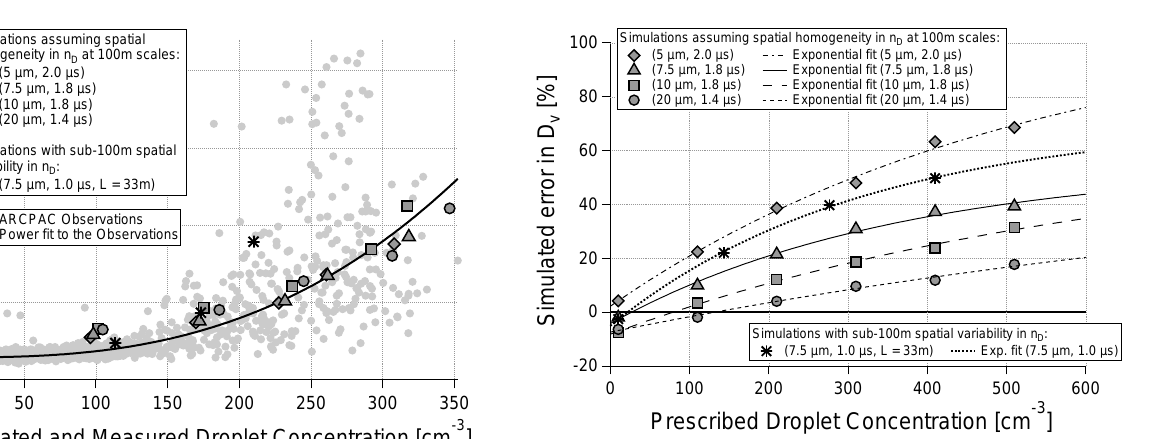
Fig. 11. Simulated and observed average transit times as a function of the simulated and measured droplet concentrations. A range of prescribed droplet sizes are chosen (5, 7.5, 10 and 20µm) in the sim- ulations, and the pulse widths are then determined for best agree- ment with the average transit times observed. The average transit times thereby provide a constraint on the pulse widths used in the simulations, and also a constraint on the coincidence errors for a given droplet size. The set of simulations including sub-sample variability in droplet concentrations results in greater coincidence errors, even though shorter pulse widths are used, and produces bet- ter agreement with the average transit time observations at both low and high droplet concentrations.